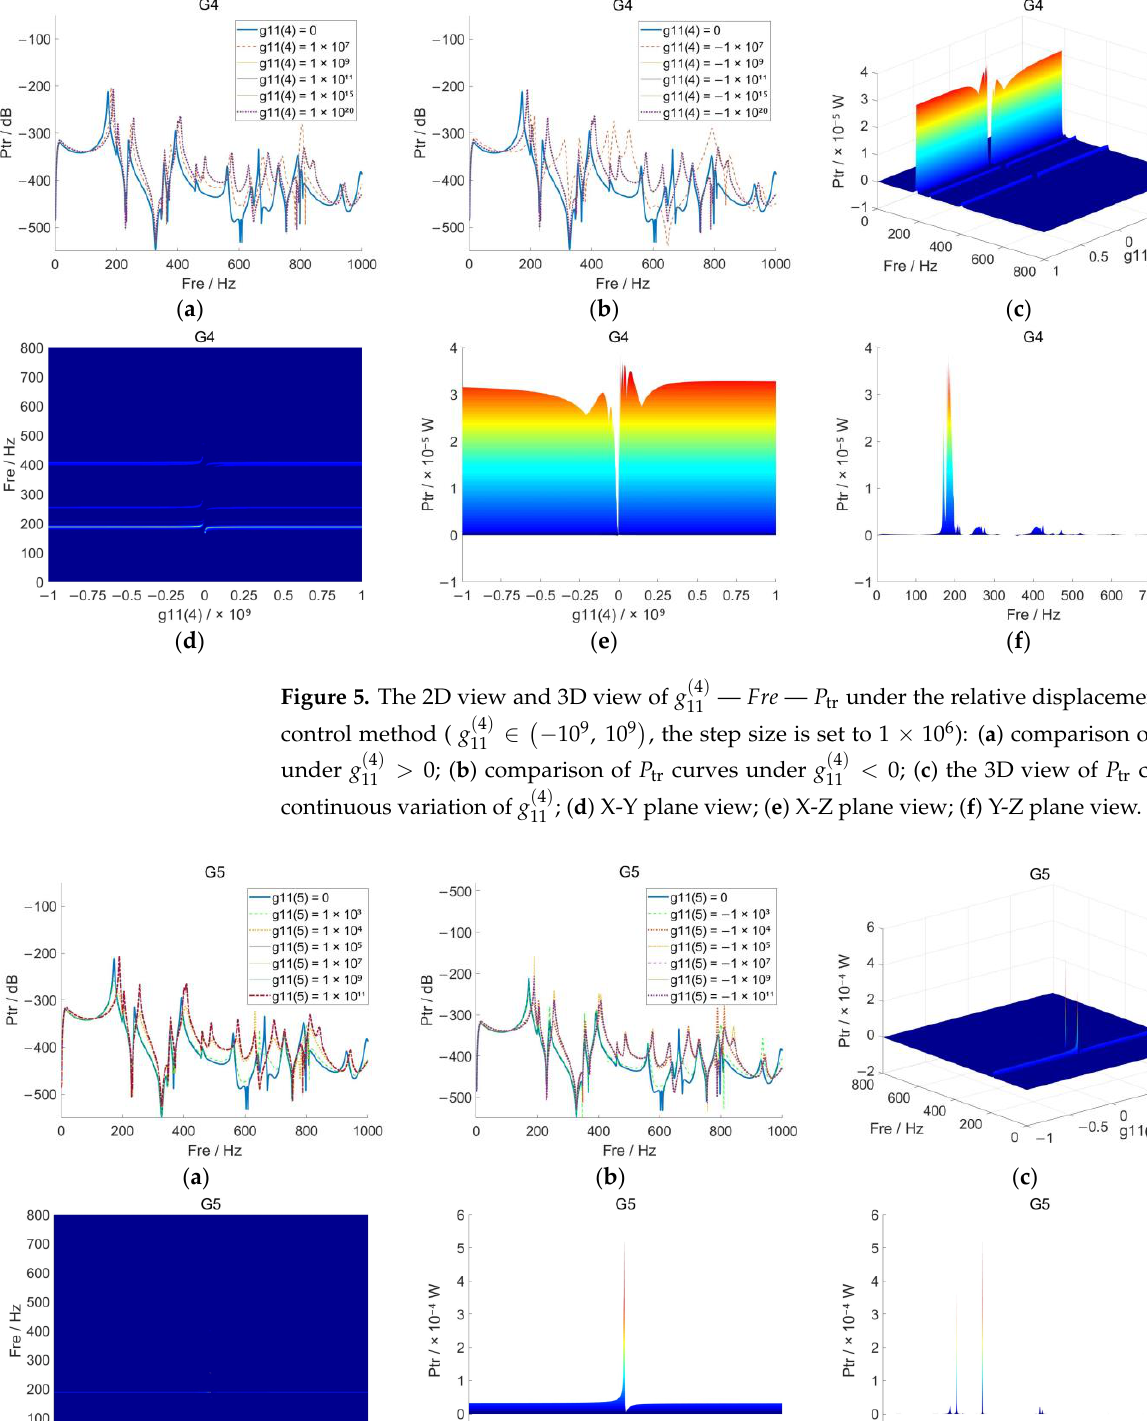
P under the absolute acceleration feedback g — Fre — Figure 4. The 2D view and 3D view of ( ) 3 11 tr control method ( ( ) ( , the step size is set to 10): ( a ) comparison of ( ) 3 P curves under ( ) 3 0 g  ; ( b ) comparison of 11 11 tr g ; ( d ) X-Y plane view; ( e ) X-Z plane view; ( f ) Y-Z plane view. variation of ( ) 3 11